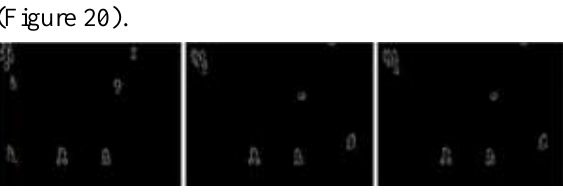
Figure 20. Edge detection of S p with canny edge detector, where p = 1, 2, and